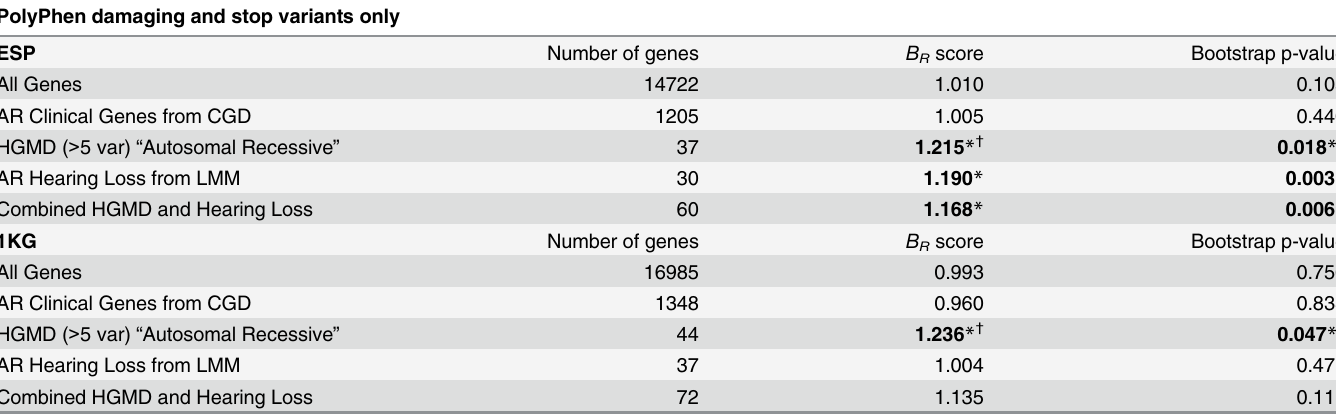
Table 1. Empirical results for autosomal recessive disease gene